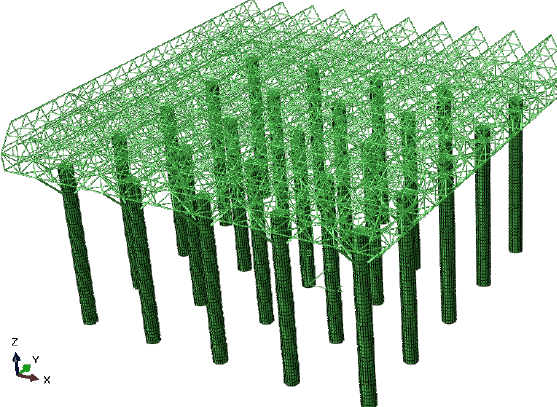
Figure 13. FE model of the prototype structure.